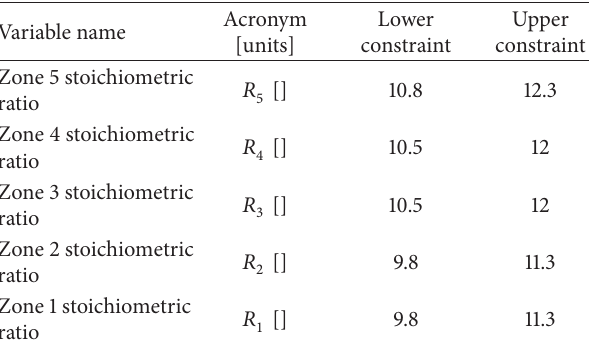
Table 6: The ratio Controlled Variables